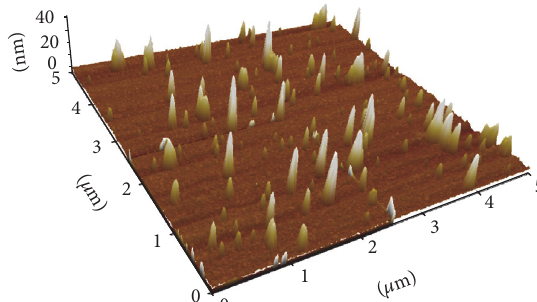
Figure 2: Synthesized AuNPs on an arbitrary substrate imaged via atomic force